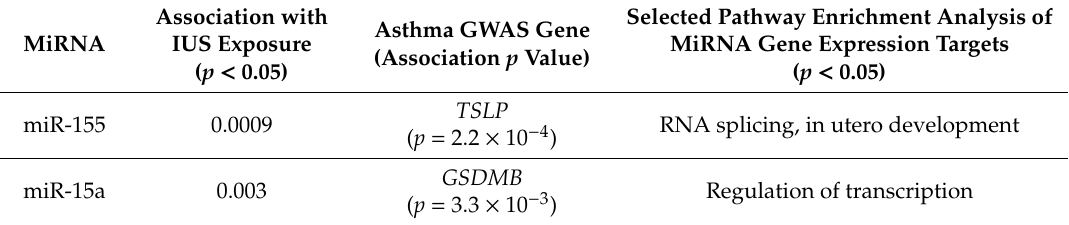
Table 4. Association of developmental IUS-associated miRNAS with the intrauterine expression of known asthma genome-wide association studies (GWAS)